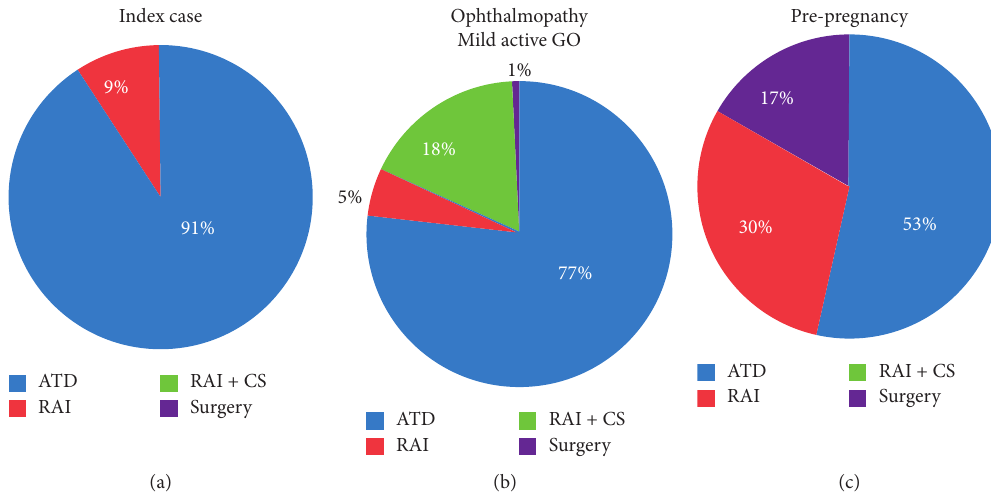
Figure 3: The effects of clinical variations on the selection of therapies for Graves’ disease. (a) Uncomplicated Graves’ disease (index case); (b) GO; (c) woman who planned to become pregnant in the next 6–12 months. ATD, antithyroid drug; CS, prophylactic corticosteroid therapy; GO, Graves’ orbitopathy; RAI, radioactive iodine. Table 1: Percentage of respondents choosing the preferred treatment modalities for the index case when GO occurs. No signs of GO; only risk factors (%) Mild active GO (%) Moderately severe and active GO (%) ATD